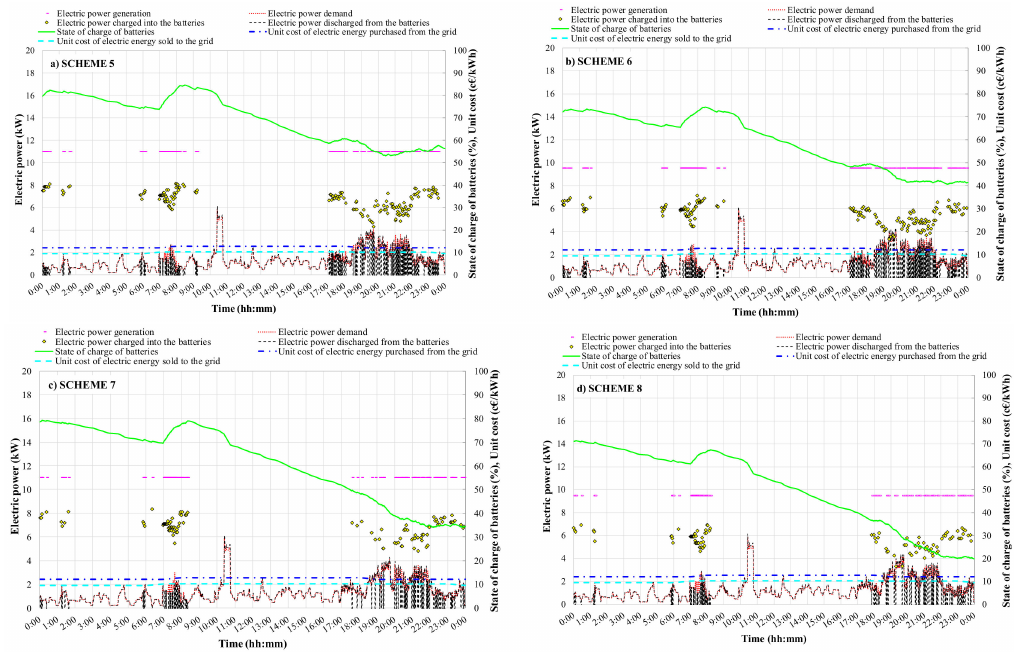
Figure 7. Main electric energy flows during a typical daily operation (1 February of the fifth simulation year) of the SCHEME 5 ( a ), SCHEME 6 ( b ), SCHEME 7 ( c ), SCHEME 8 ( d